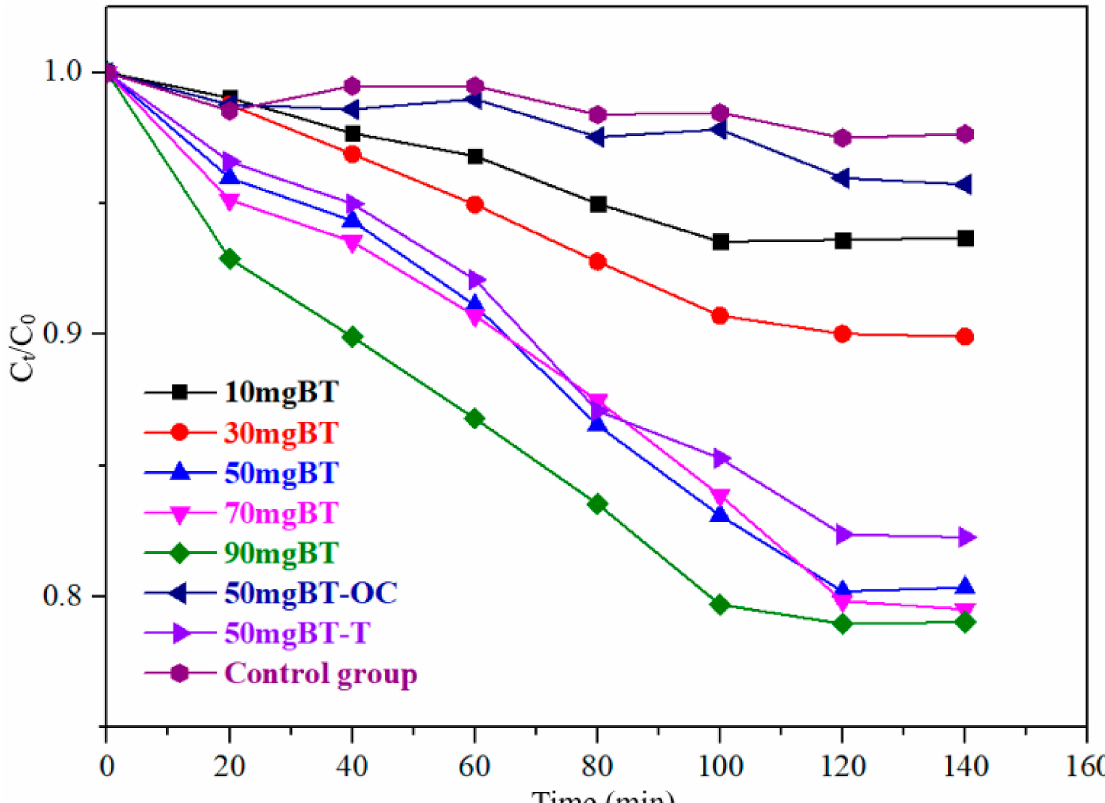
Figure 5. The adsorption effect curves of RhB on different